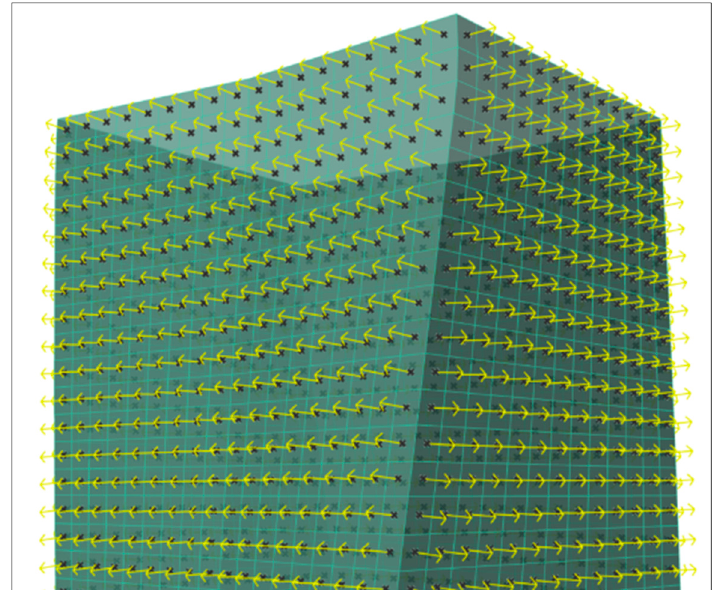
Figure 13. Building mesh faces and normal.